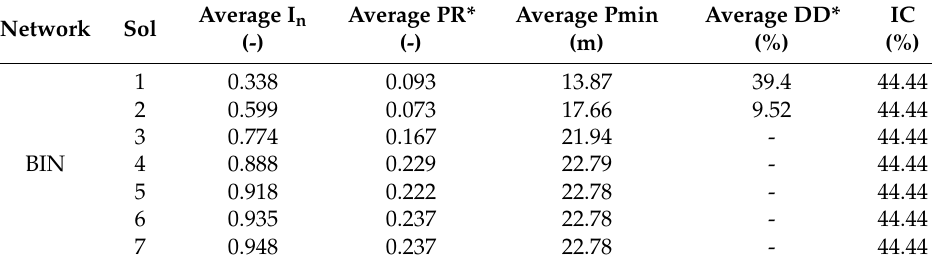
Table 12. Average characteristics of BIN solutions among all the